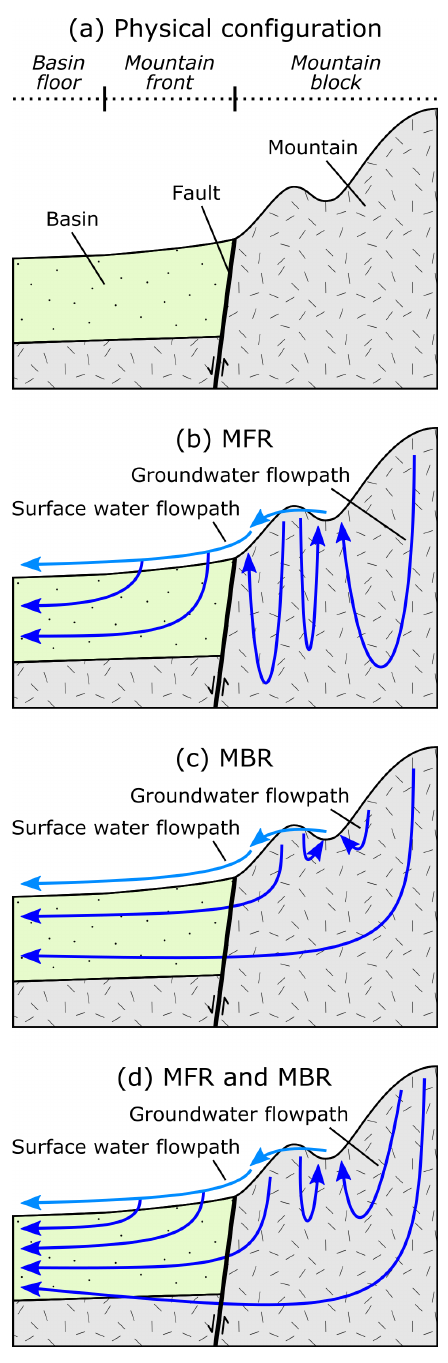
Figure 1. Conceptual models of the transition between mountain and basin: (a) physical configuration and (b–c) possible conceptu- alizations of MSR where (b) MFR dominates, (c) MBR dominates, and (d) both MFR and MBR are